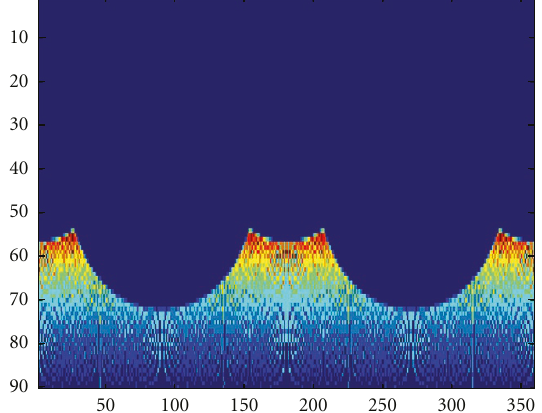
Figure 13: Optimized radiation intensity pattern of the transmitter (see